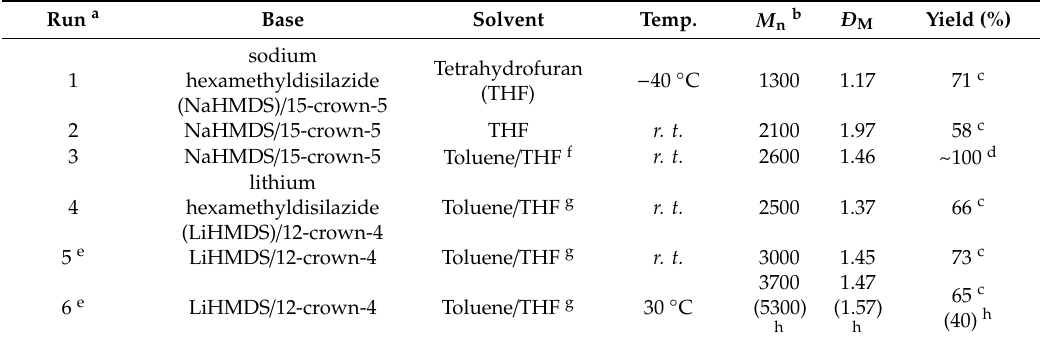
Table 1. Polymerization of N -(2-ethylhexyl)oxindolidene thienylene vinylene (OTV) based on the aldol condensation reaction.